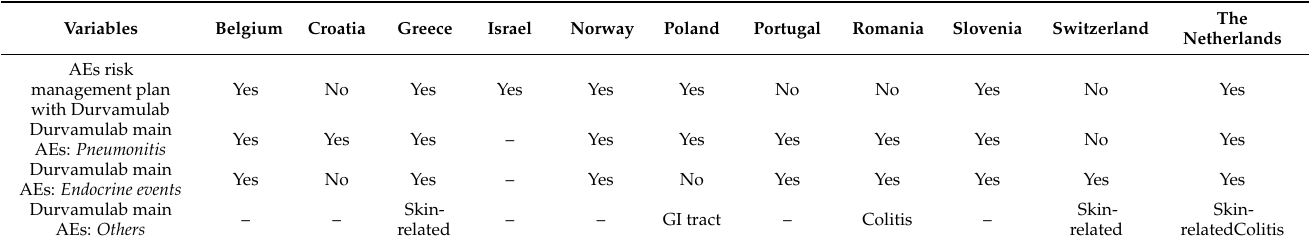
Table 5. Safety and tolerability of Durvamulab in daily clinical practice.